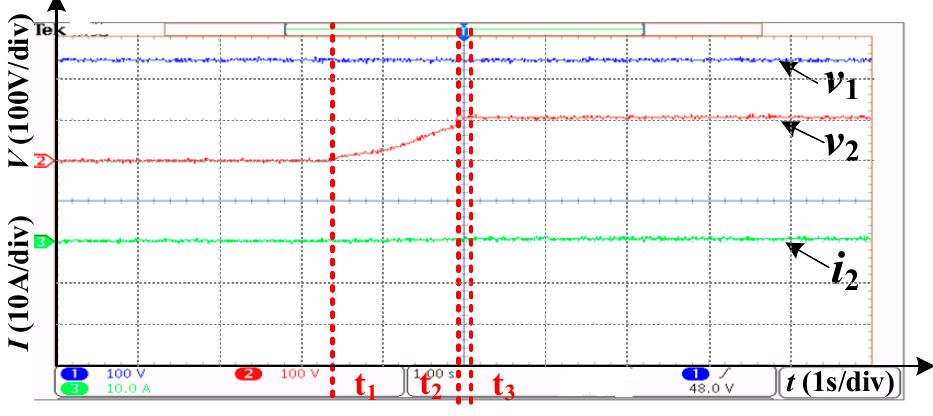
Figure 8. Waveforms in starting experiment.